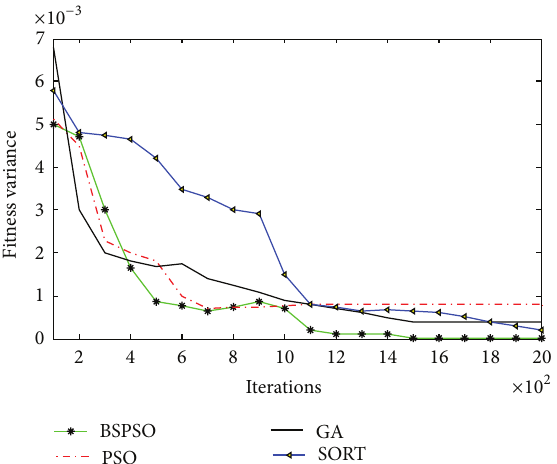
Figure 4: Simulation result of the optimal solution efficiency.